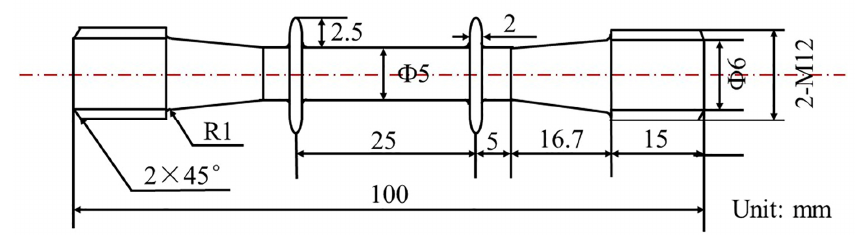
Figure 1. Sketch of the creep specimens.